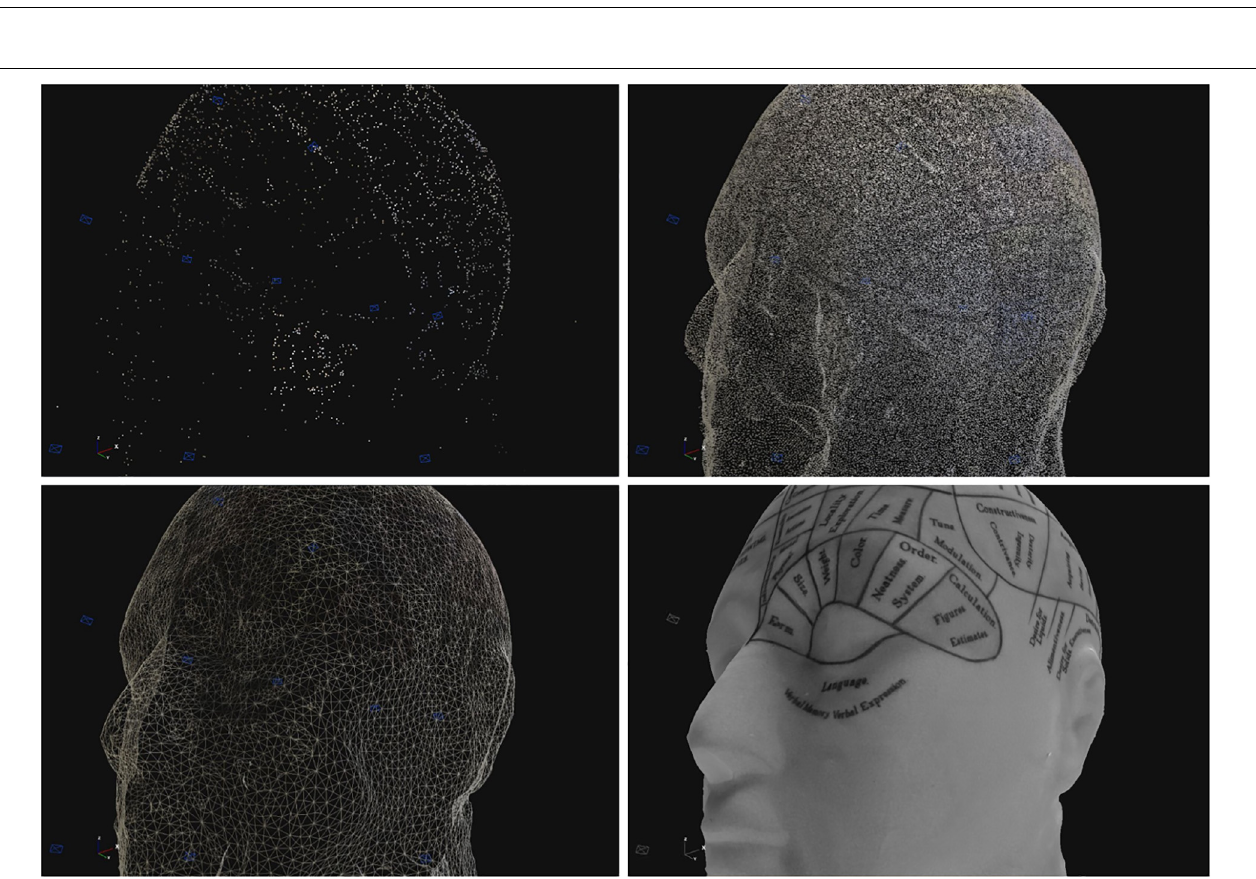
FIGURE 2 | A sparse point cloud (top left) , a dense point cloud (top right) , a polygon mesh (bottom left) , and a textured mesh (bottom right) ; screenshots taken in 3DF Zephyr Lite (3Dflow, 2019).